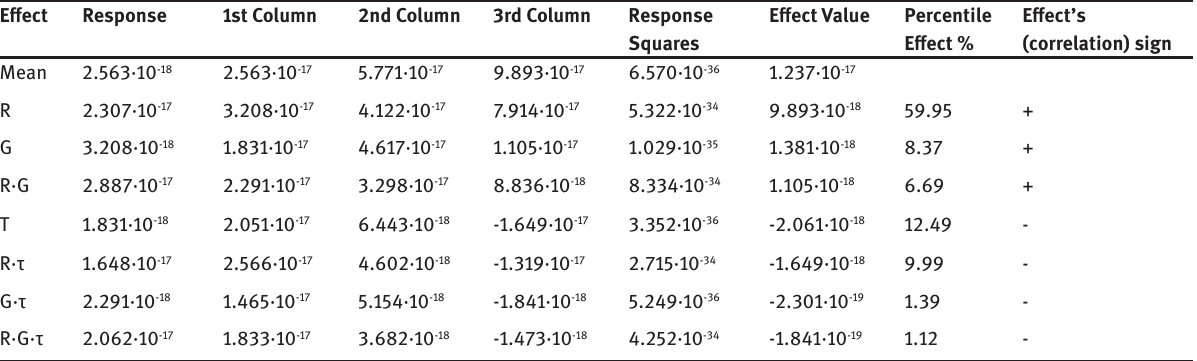
Table 8: Yates Analysis.